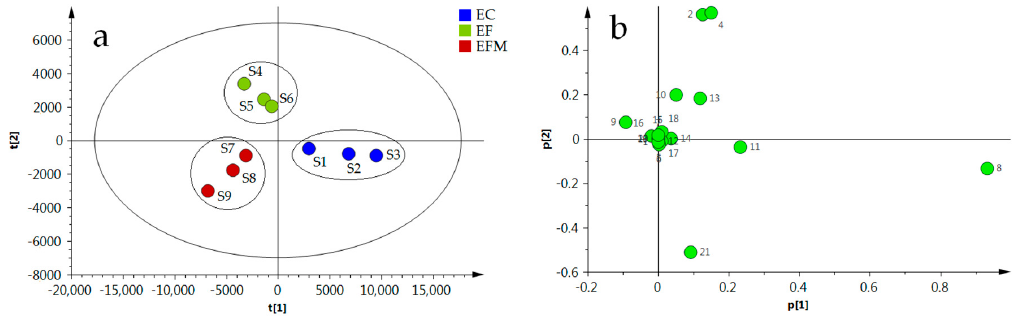
Figure 2. PCA score scatter plot ( a ) and PCA loading plot ( b ) of different parts of EU .